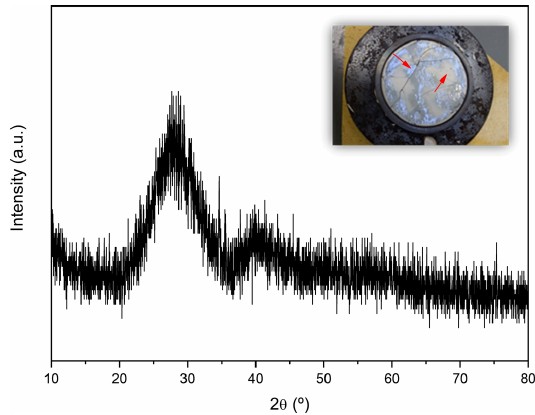
Figure 1. XRD patterns of the Ca Glass. Inset: Photograph of Ca Glass still in the metal mold where it was poured. The arrows point to two apparently distinct